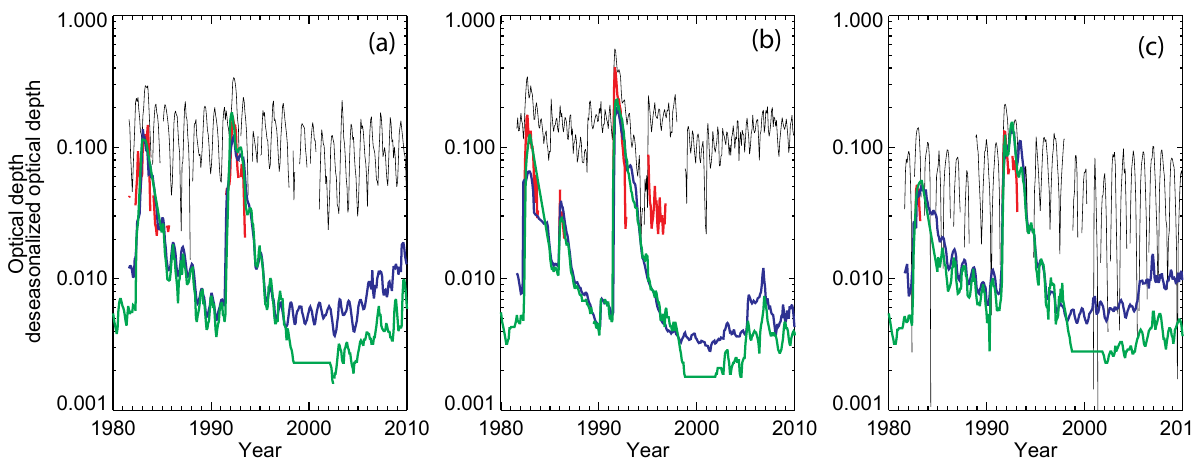
Figure 17. Comparison of total stratospheric aerosol optical depth at northern midlatitudes, the tropics, and southern midlatitudes at 525 (SAGE II/GISS) and 550nm (AVHRR). AVHRR is shown in black, AVHRR with a 28-year median annual cycle removed is red, GloSSAC is shown in blue, and the GISS data set is shown in